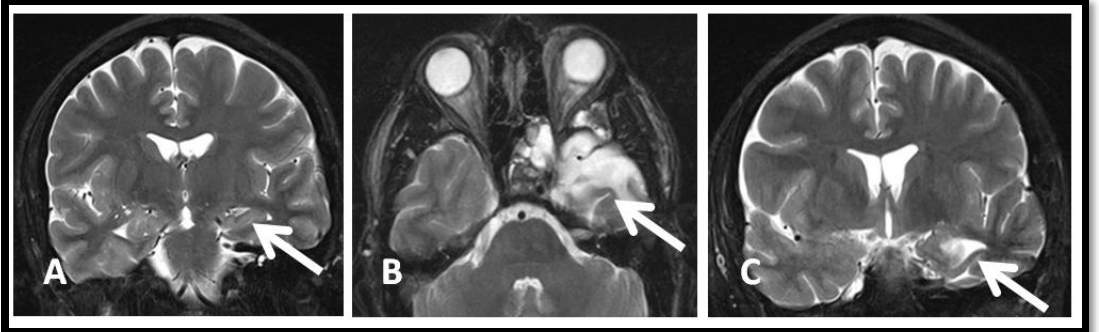
Figure 4. One year post operative brain MRI. ( A ) Coronal T2 sequence showing preserved left hippocampus (arrow). ( B ) Axial T2 sequence showing resected left temporal pole (arrow). ( C ) Coronal T2 sequence showing left amydalectomy (arrow).